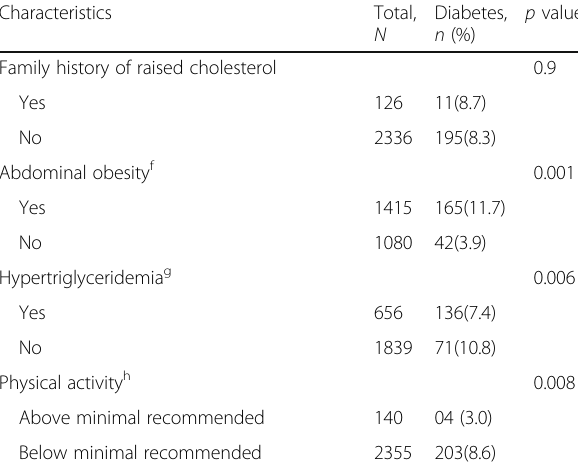
Table 1 Characteristics of study participants and the prevalence of diabetes by sociodemographic and clinical factors